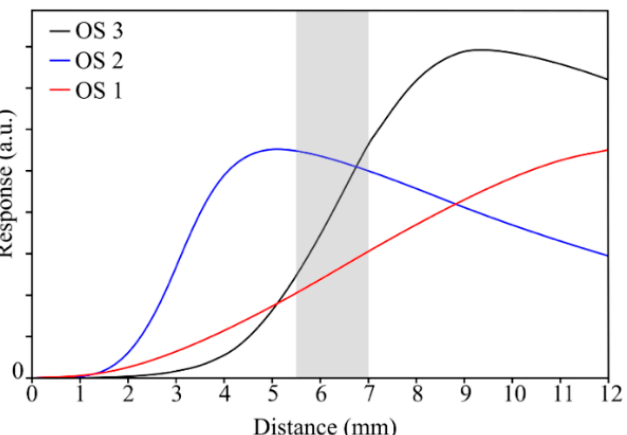
Figure 4. Response curve of the three optical sensors OS 1, OS 2 and OS 3 as a function of the distance from the surface of interest to the tip of the sensor. The shaded region defines the working region of interest. OS 1: Commercial optical sensor from Philtec (RC171). OS 2 and OS 3: Custom-designed sensors that operate in the back and front slope regions (second and first linear regions), respectively.